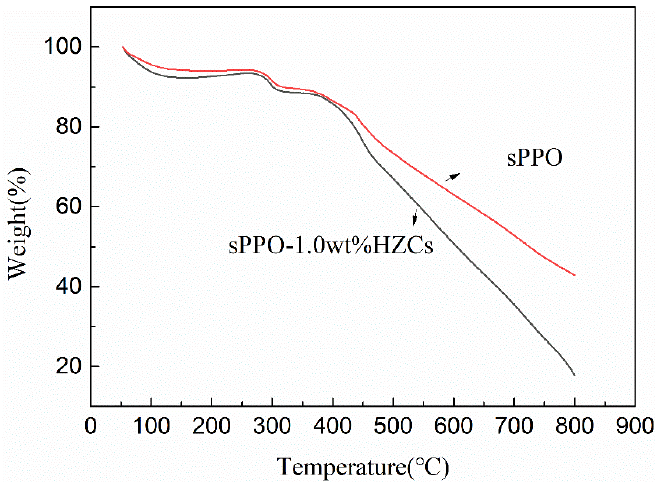
Figure 5. TGA of the membranes before and after HZCs loading (1.0 wt.% HZCs). The mechanical properties of the membranes at different HZCs loadings are shown in Figure 6.